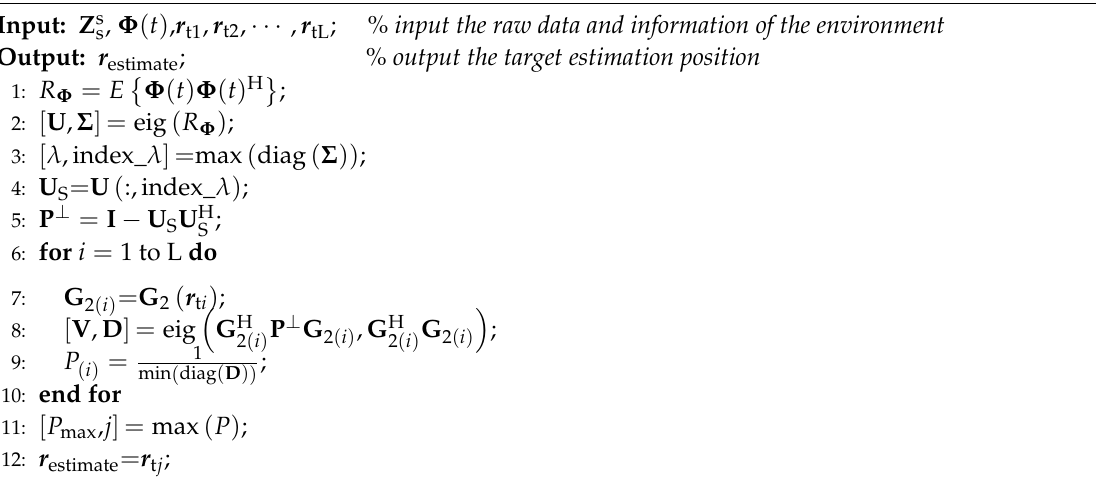
Algorithm 1 Locating the target based on the MP-MUSIC